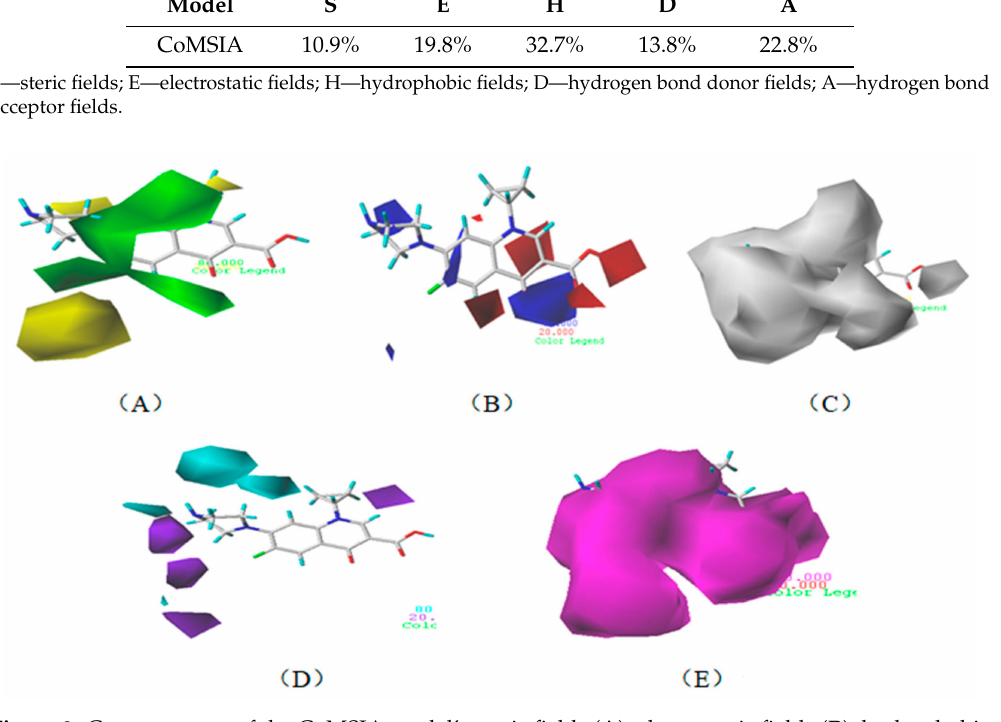
Figure 2. Contour maps of the CoMSIA model’s steric fields ( A ), electrostatic fields ( B ), hydrophobic fields ( C ), hydrogen bond donor fields ( D ), and hydrogen bond acceptor fields ( E